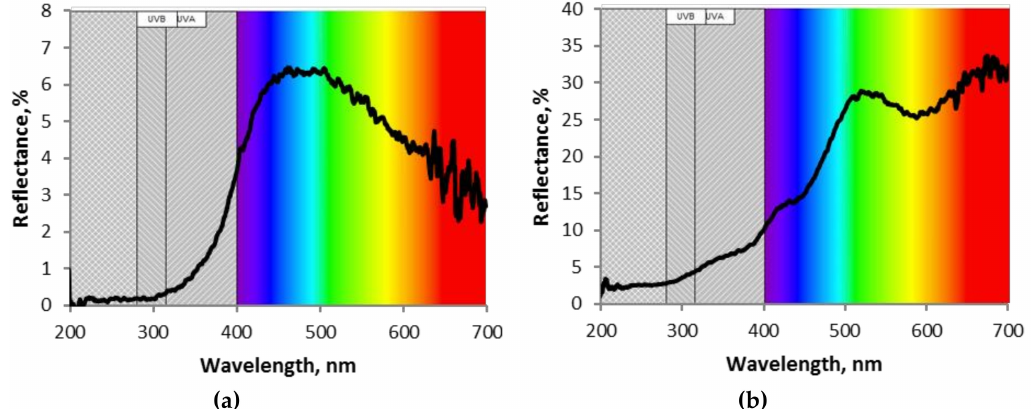
Figure 3. The diffuse reflectance spectra of the aerosol assisted chemical vapor deposited ( a ) tungsten oxide and ( b ) cerium oxide films without